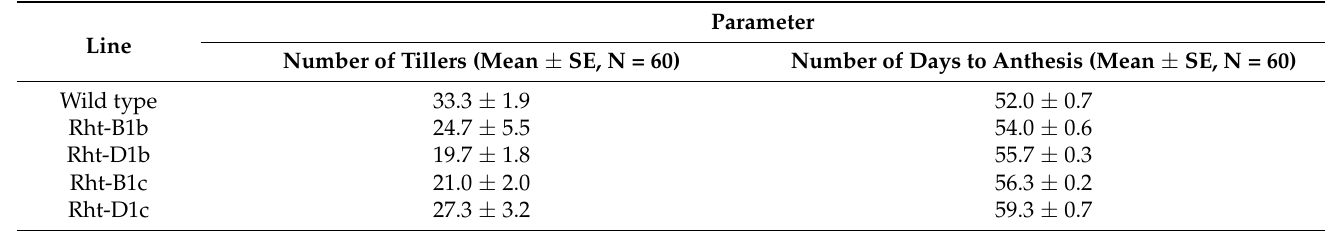
Table 1. Variation in number of tillers and days to anthesis by line (Wild type, Rht-B1b, Rht-D1b, Rht-B1c, and Rht-D1c).